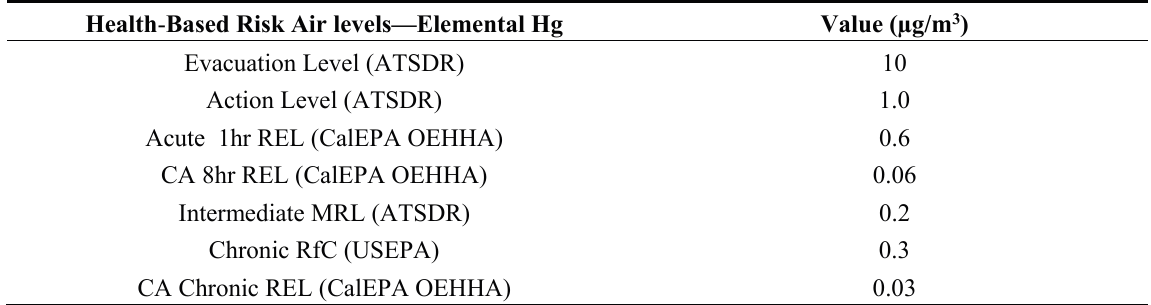
Table 3. Health-Based Risk and Action Levels for Elemental Mercury in